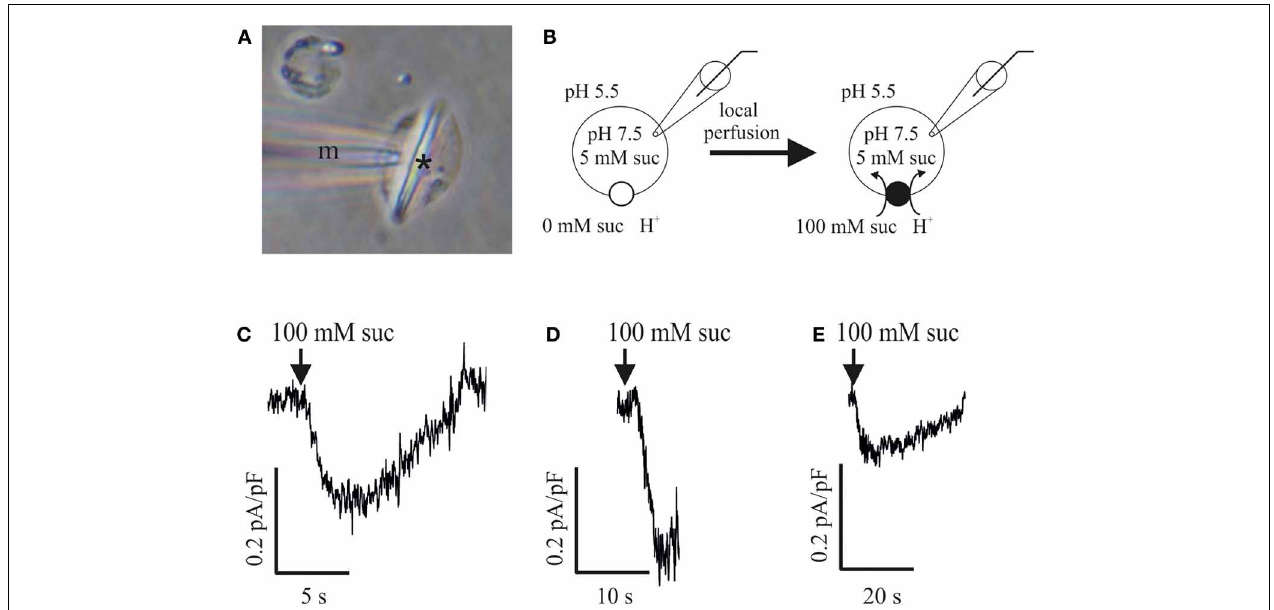
FIGURE 2 | Patch clamp recordings of sucrose-induced H + currents in sieve-element(SE) protoplasts of Vicia faba . (A) SE protoplast containing a forisome (asterisk) with microcapillary (m) attached to the plasma membrane immediately before a patch-clamp experiment. (B) Experimental patch-clamp conditions with 5mM sucrose at the inner side of an SE protoplast (pipette pH 7.5) and 0mM sucrose at the beginning of the experiment (left) and